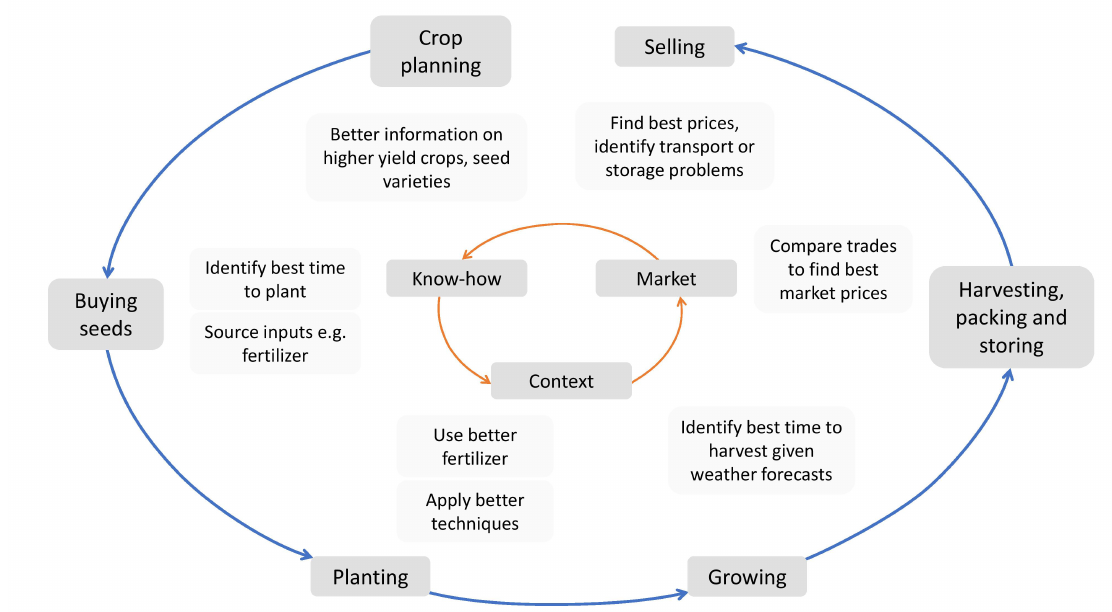
Figure 1. Information needed from farmers through the agricultural cycle (Adapted from Reference